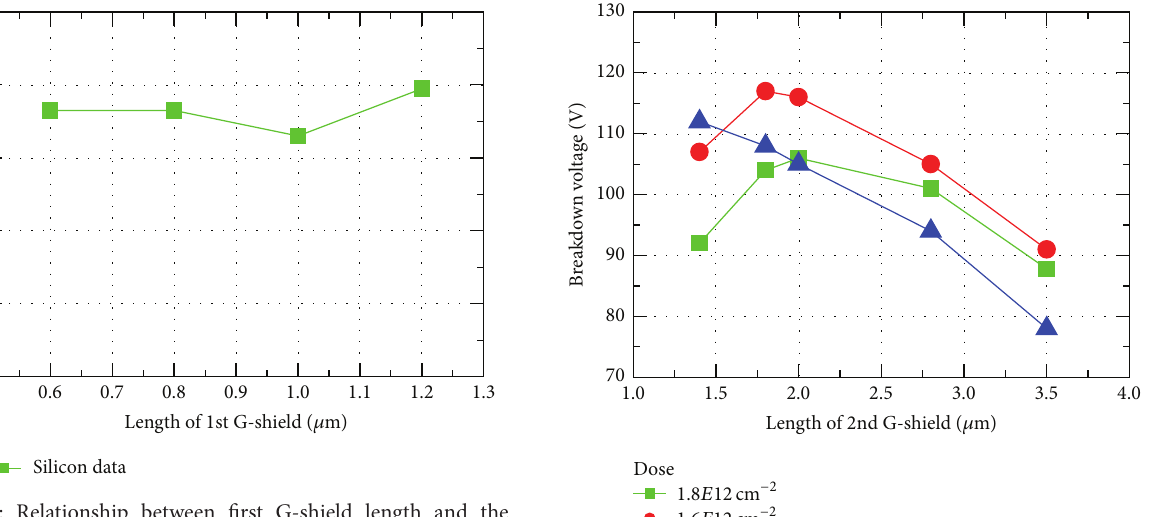
Figure 6: Relationship between first G-shield length and the breakdown voltage for a fixed length of 2nd G-shield and other conditions.